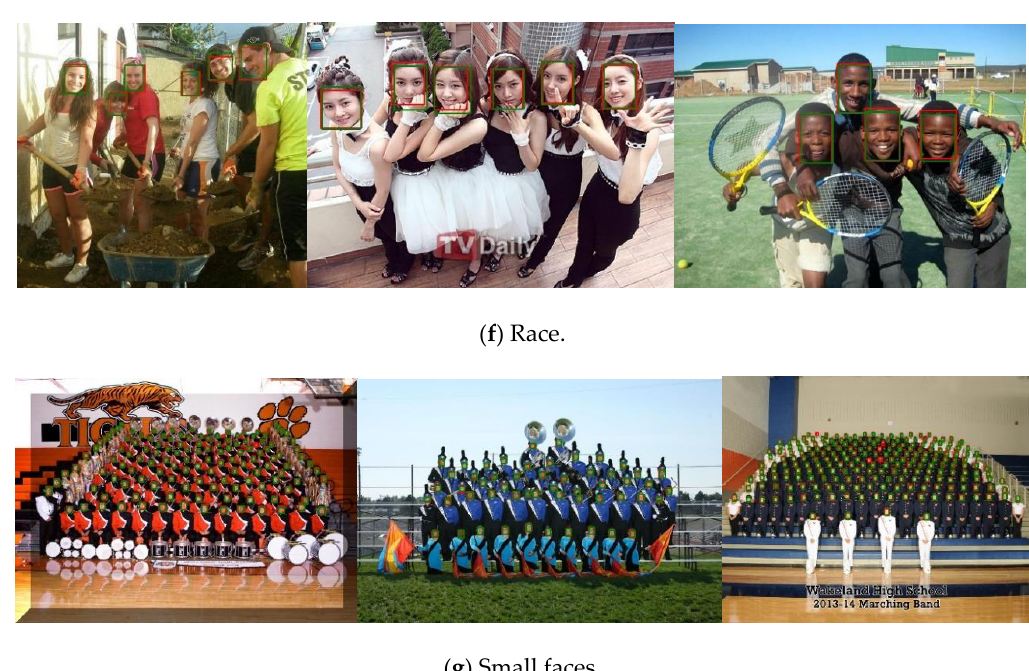
Figure 7. Qualitative results under various challenging conditions, i.e., illumination, pose changes, occlusion, race and etc. Ground truth bounding boxes are in red and predicted bounding boxes are in green. (Zoom in to see better).